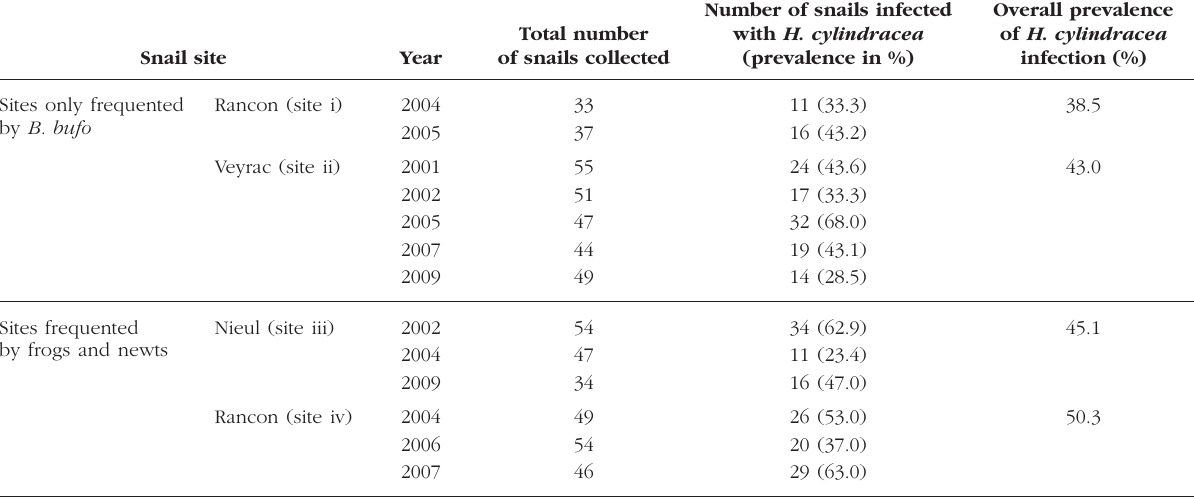
Table I. – Total number of G. truncatula collected from each site and overall prevalence of H. cylindracea infection between 2001 and